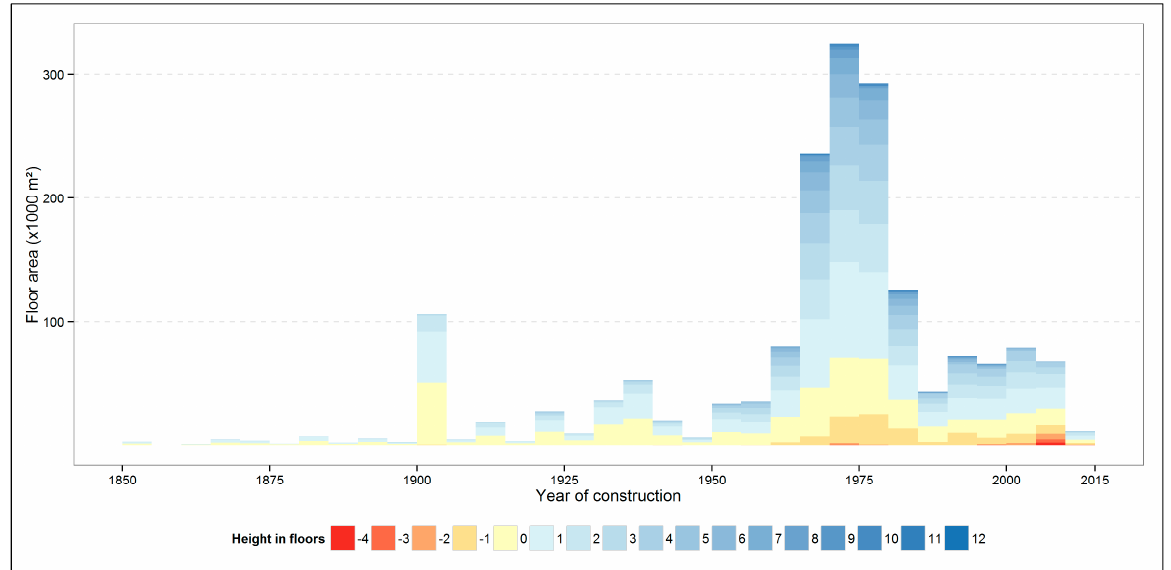
Figure 24. Weighted histogram of built area per year of construction and